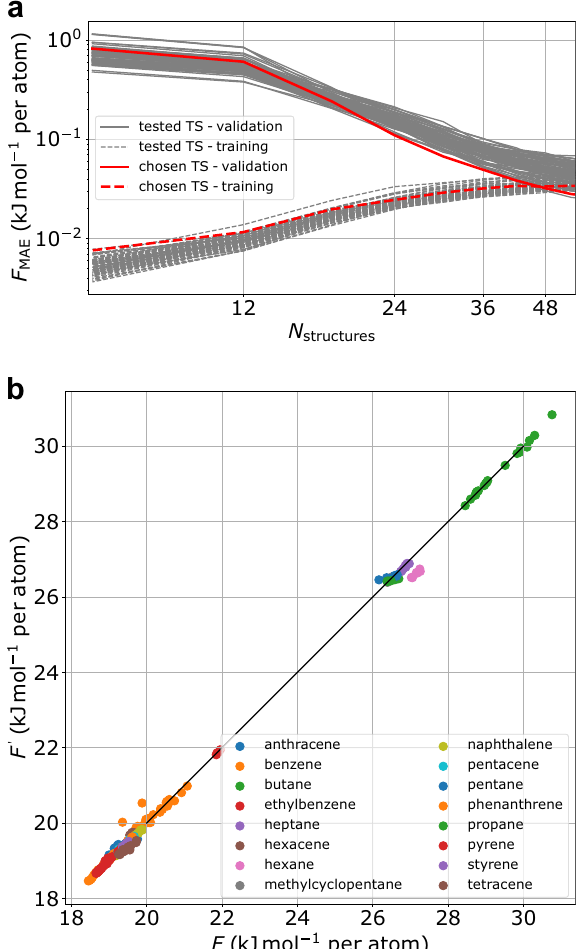
Fig. 1 Performance of the developed prediction model. a Learning curves obtained for 100 randomly chosen learning sets out of total 444 in gray, and the chosen learning set with the highest recorded value of I ( N m ) in red. Data was obtained using SOAP representation and the classical force fi eld model with the free energy calculated at 300K. b Correlation between predicted and calculated free energies at 300 K (classical force fi eld, SOAP representations). Different crystal families are represented by different colors.